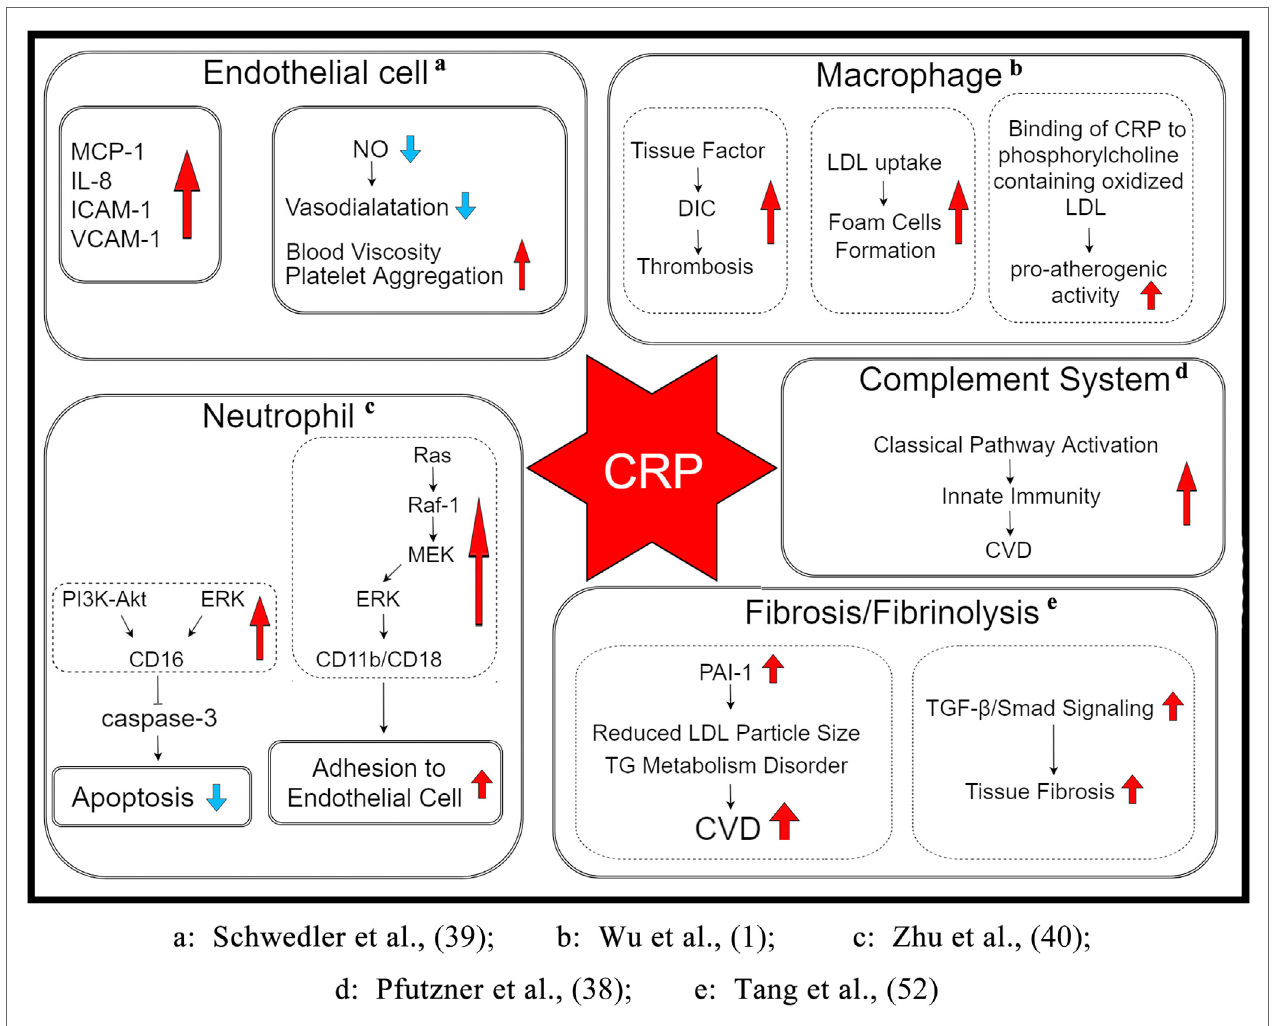
FigURe 1 | The potential mechanism underlying the role of CRP in the pathogenesis of CVDs. CRP may be involved in various stages through its direct influence on pathophysiological processes such as the activation of endothelial cells and macrophages, inhibition of apoptosis of neutrophils and expression of endothelial NO synthase, stimulation of the complement cascade, enhancement of PAI-1 activity and LDL uptake, accumulation of lipid and thrombosis, and upregulation of pro-inflammatory cytokine expression. Abbreviations: DIC, disseminated intravascular coagulation; LDL, low-density lipoprotein; CVD, cardiovascular diseases; TG, triglyceride; MCP-1, monocyte chemoattractant protein 1; ICAM-1, intercellular adhesion molecule 1; VCAM-1, vascular cell adhesion molecule 1; NO, nitric oxide; PI3K, phosphatidylinositol 3-kinase; ERK, extracellular signal-regulated kinase; MAPK, mitogen-activated protein kinase; PAI-1, plasminogen activator inhibitor-1; TGF- β , transforming growth factor- β ; CRP, C-reactive